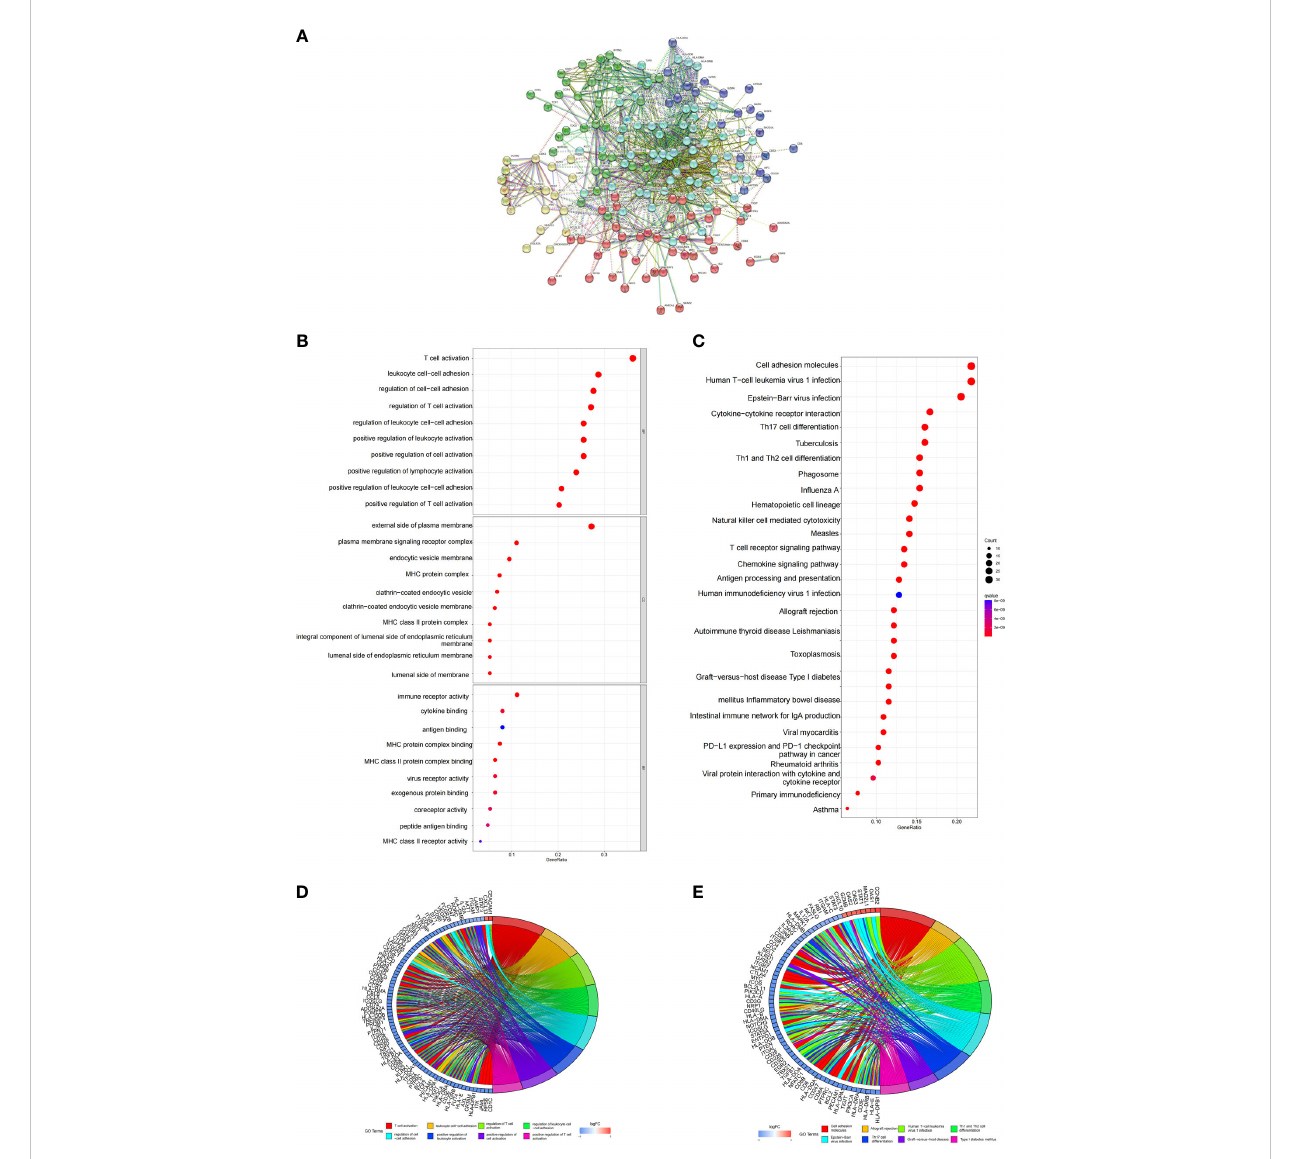
FIGURE 3 PPI networks of DEGs, and functional analysis. (A) PPI network of DEGs. Disconnected nodes are hidden. (B, C) The top GO items enriched for DEGs. (D, E) KEGG pathway enrichment results for